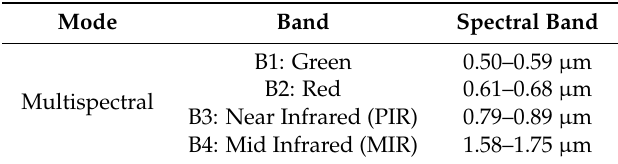
Table 2. Bands characteristics of the satellite SPOT4 and